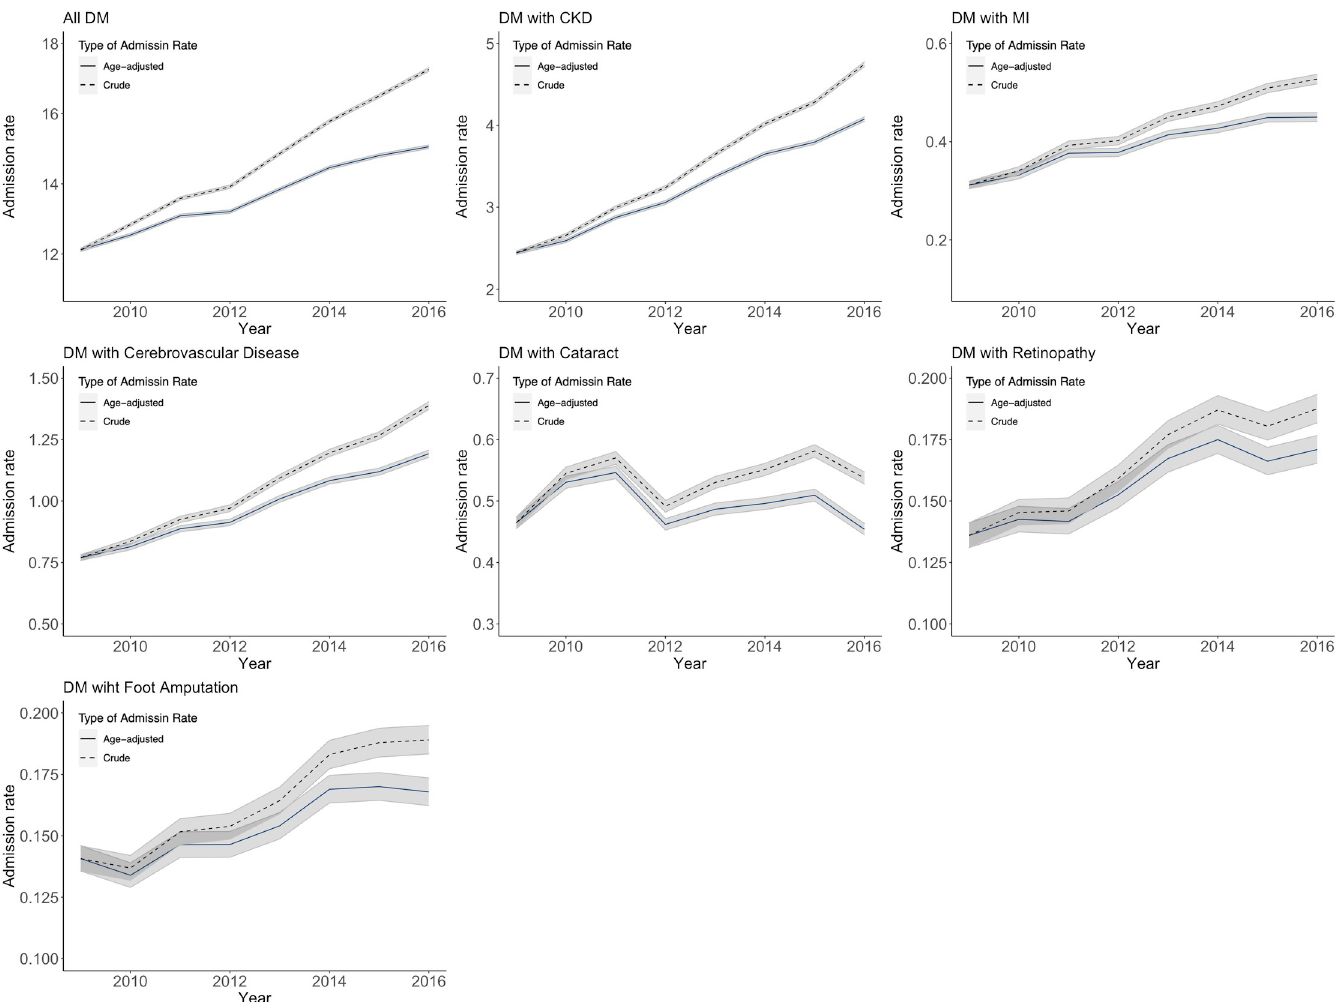
Fig 4. The crude and age-adjusted admission rates of type 2 diabetes mellitus with the six major complications under the Universal Coverage Scheme in Thailand from 2009 to 2016. Note: The crude admission rate is the number of admissions divided by the number of the UCS population. The age-adjusted admission rate is calculated by the direct method with the 2009 population as the standard population. The gray bands indicate the 99% confidence interval.